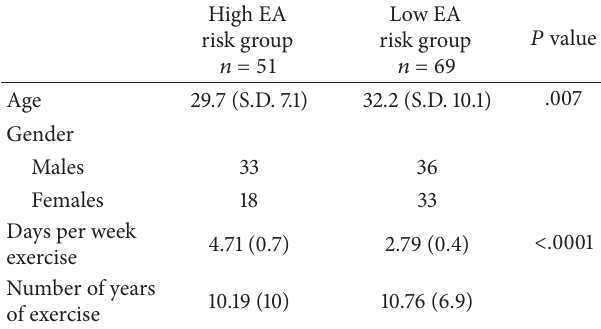
Table 1: Demographic characteristics and frequency of exercise